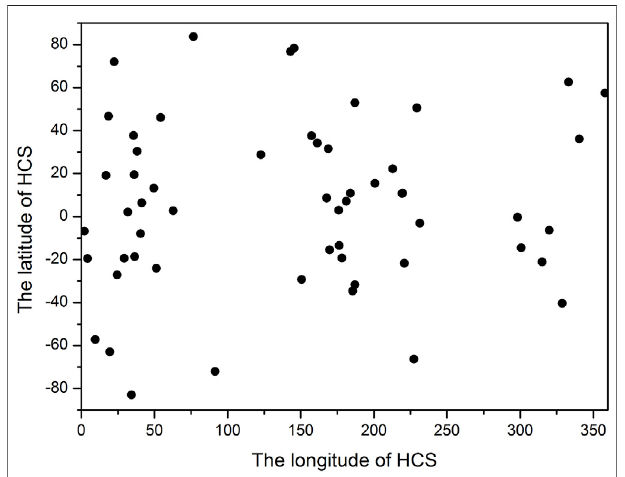
FIGURE 5 | The distribution of the angle between the axis of the rope and the normal of the associated HCS as a function of the duration of the fl ux ropes. The red dots represent the SIMFRs of CAT1 category. The black squares represent SIMFRs of CAT2 category.